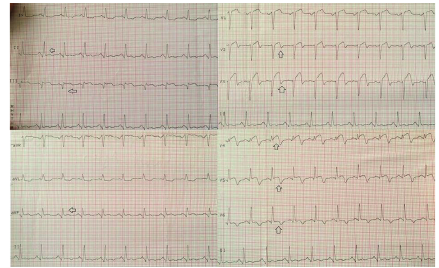
Figure 2: Partial ST segment resolution after fibrinolytic therapy in precordial leads.